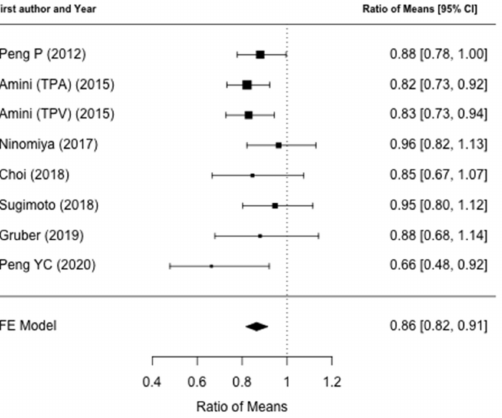
Figure 6. Forest plot for the difference ratio of overall survival. Meta-analysis identified that patients with low muscle mass who underwent pancreatic resection demonstrated a significantly reduced OS when compared to patients without alterations of the muscle mass.